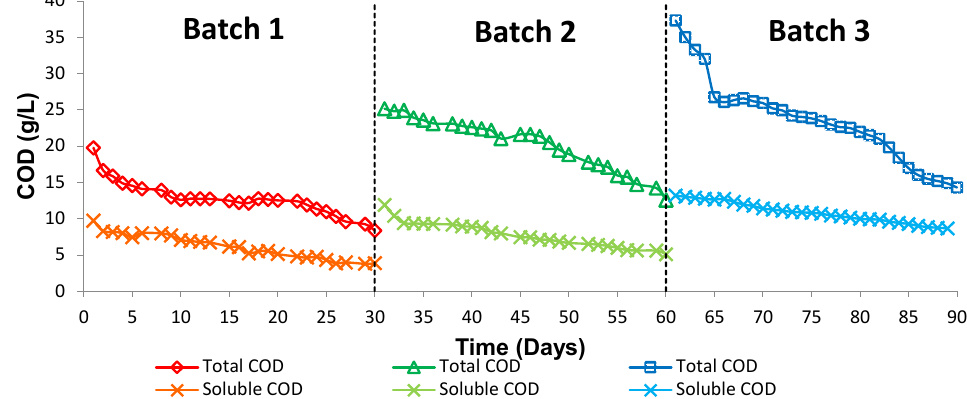
Figure 3. Behavior of the total chemical oxygen demand (COD) and soluble COD.